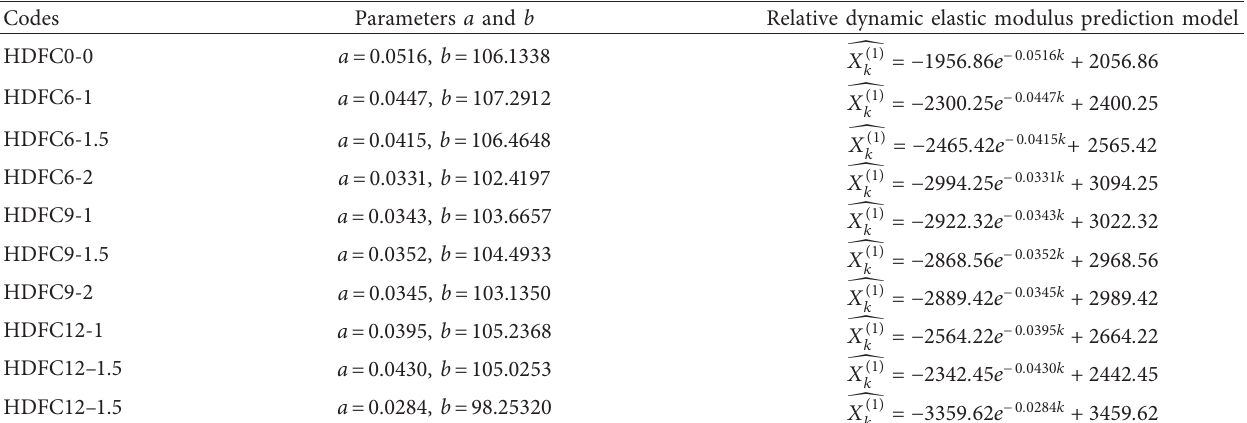
Table 7: Prediction model and coefficient of relative dynamic elastic modulus of